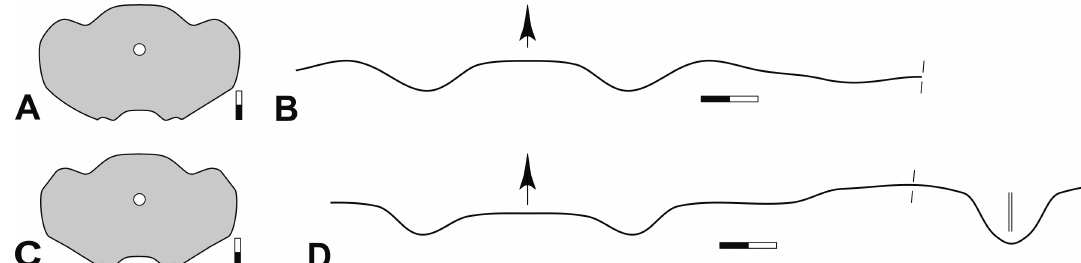
Fig. 24. Trilobitoceras peculiaris sp. nov. from Oued Temertasset (both Korn et al . 2002 Coll.). A . Whorl profile of holotype MB.C.30477 (dorsal portion reconstructed). B . Suture line of holotype MB.C.30477, at ww = 13.6 mm, wh = 7.7 mm. C . Whorl profile of paratype MB.C.30478. D . Suture line of paratype MB.C.30478, at ww = 13.6 mm, wh = 7.9 mm. Scale bar units = 1 mm.